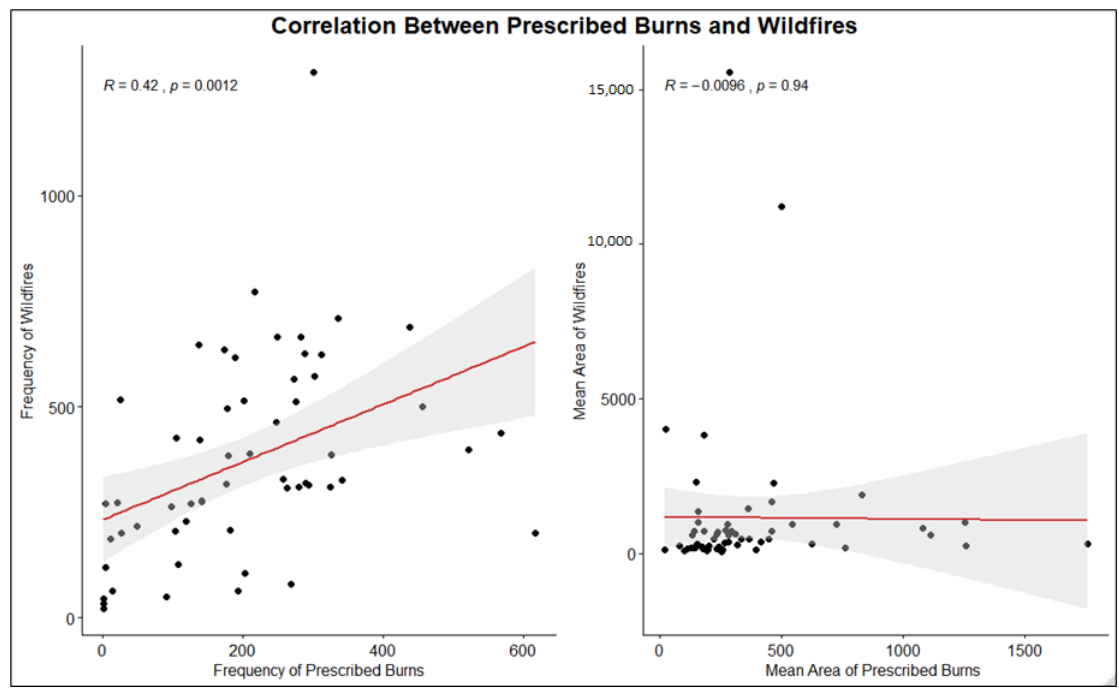
Figure 12. Correlation between prescribed burns and bushfires.